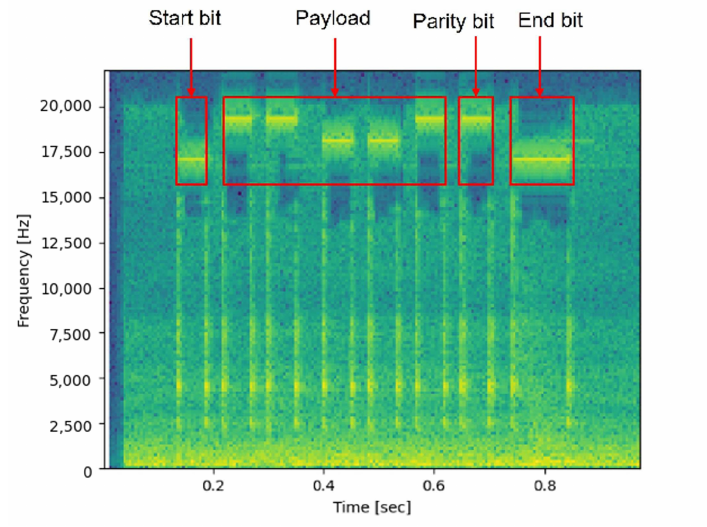
Figure 3. Spectrogram of sound transferring binary code “11001” using beep sound.